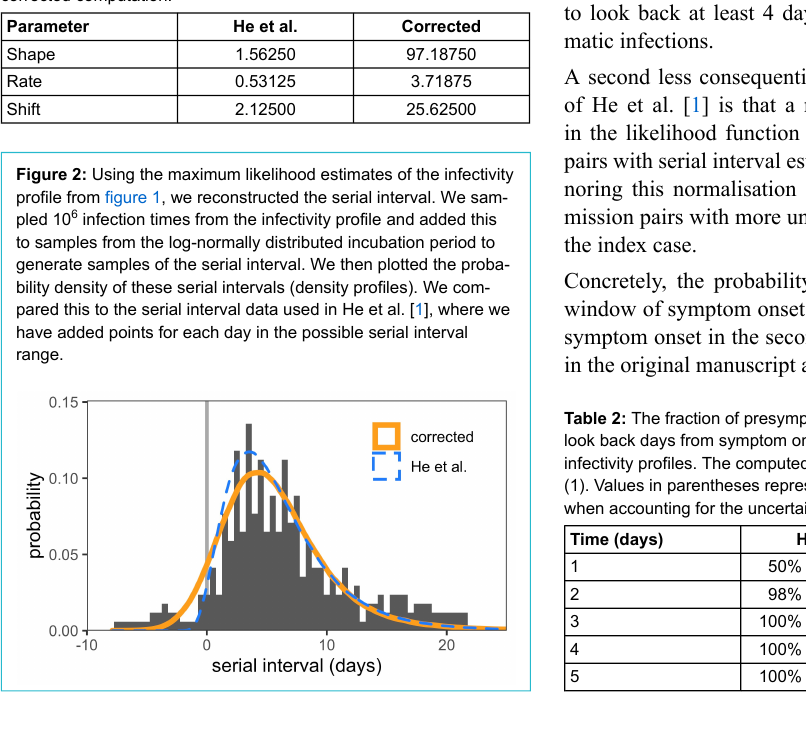
Table 1: Maximum likelihood parameter estimates based on our adap- tive grid search approach using the method of He et al. [1] and the corrected computation.